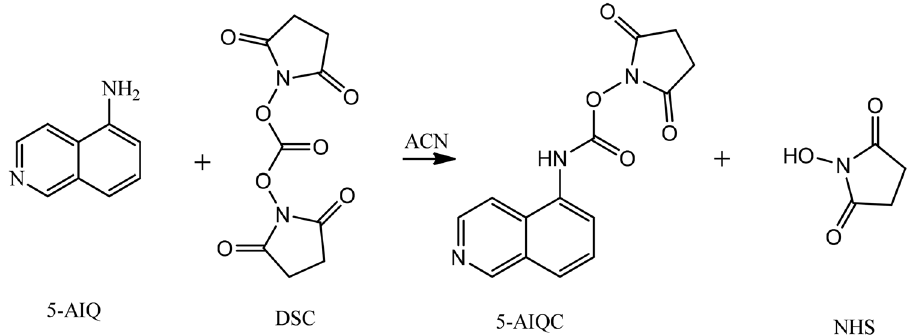
Figure 1. Synthesis of 5-aminoisoquinolyl-N-hydroxysuccinimidyl carbamate (5-AIQC).